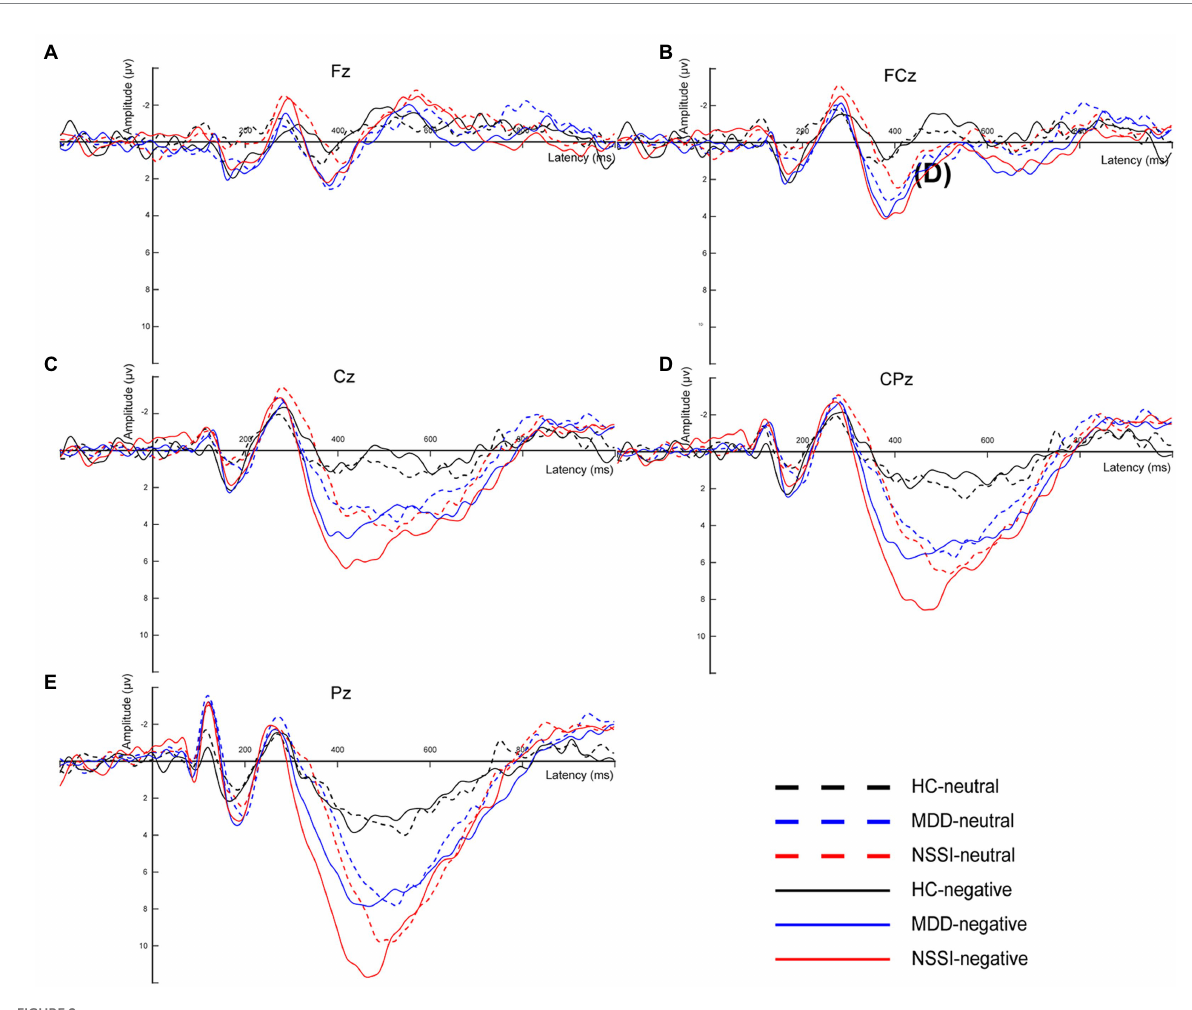
FIGURE 2 (A) The average difference waveforms at Fz electrode under neutral and negative emotional cues in the HC, MDD and MDD+NSSI groups. (B) The average difference waveforms at FCz electrode under neutral and negative emotional cues in the HC, MDD and MDD+NSSI groups. (C) The average difference waveforms at Cz electrode under neutral and negative emotional cues in the HC, MDD and MDD+NSSI groups. (D) The average difference waveforms at CPz electrode under neutral and negative emotional cues in the HC, MDD and MDD+NSSI groups. (E) The average difference waveforms at Pz electrode under neutral and negative emotional cues in the HC, MDD and MDD+NSSI groups. HC, healthy control; MDD, major depressive disorder; MDD+NSSI, MDD with nonsuicidal